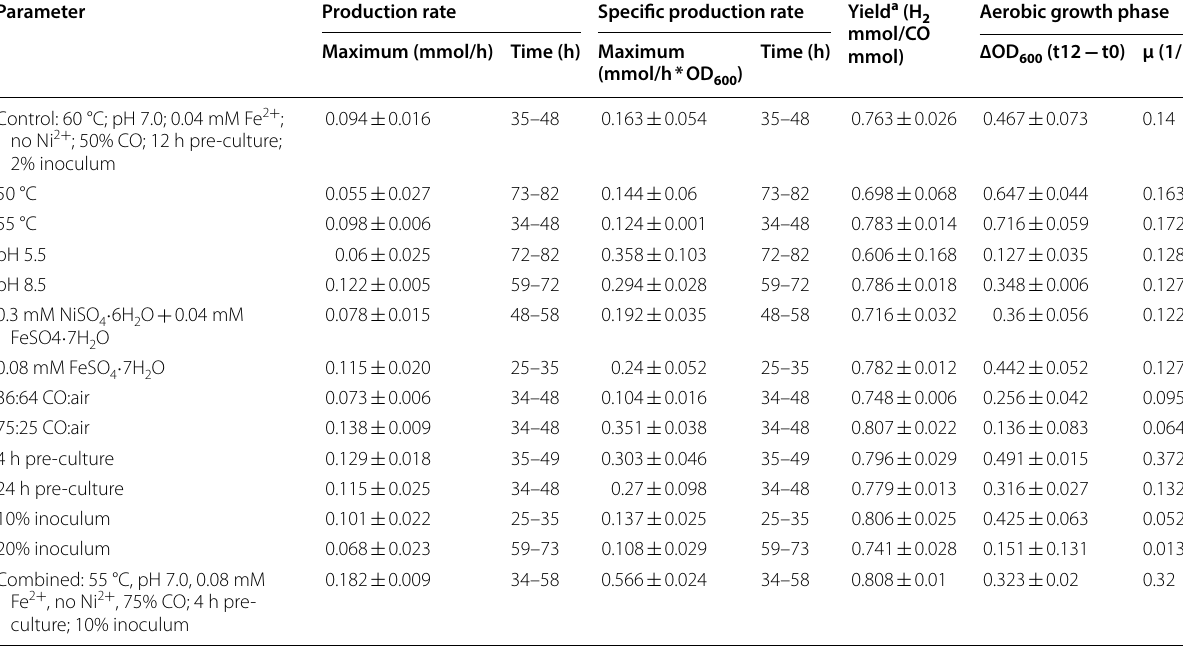
Table 2 Hydrogen production rate (mmol/h), specific production rate (mmol/h/OD and growth rates for the individual and combined